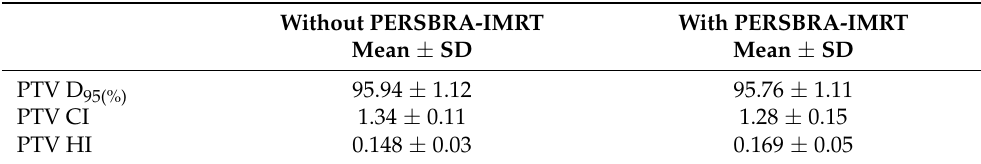
Table 2. Comparison of the planning target volume coverage without and with PERSBRA in intensity- modulated radiation therapy. Without PERSBRA-IMRT With PERSBRA-IMRT